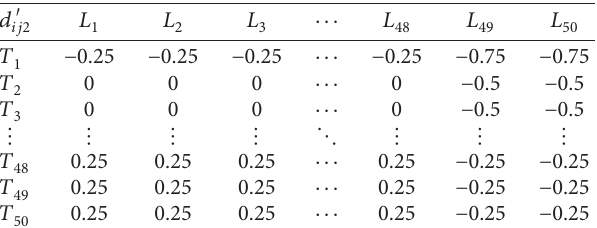
Table 13: Normative profit and loss matrix D tenants’ transportation convenience.